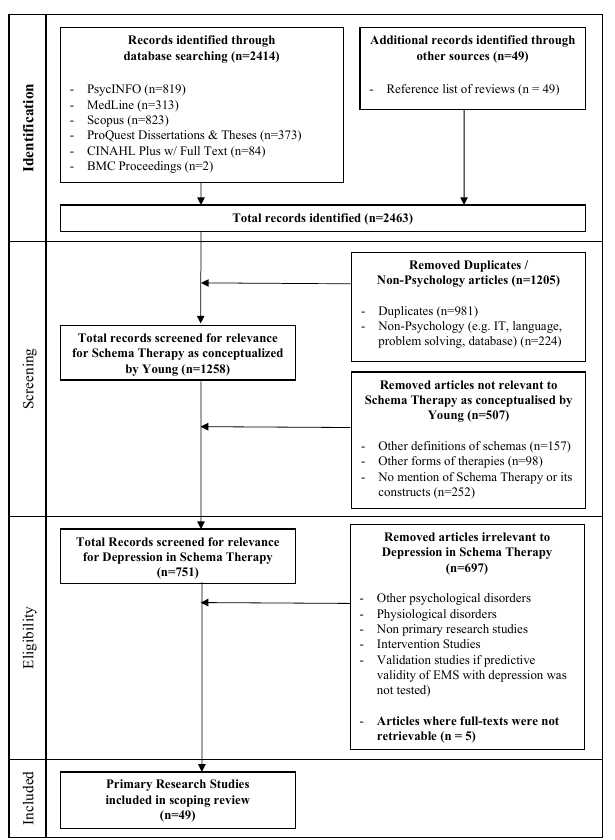
Figure 2. Full screening process in accordance to PRISMA guidelines.